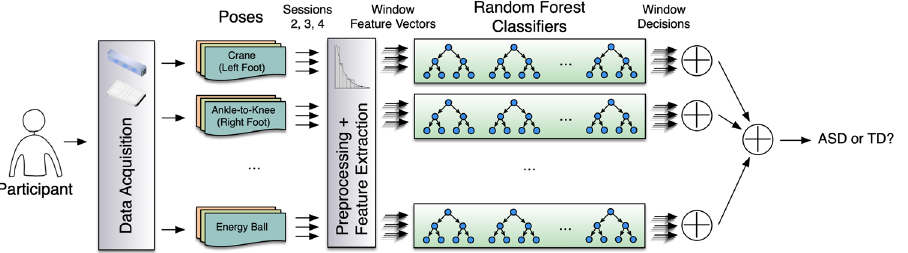
Figure 5. Architecture of our data acquisition and analysis